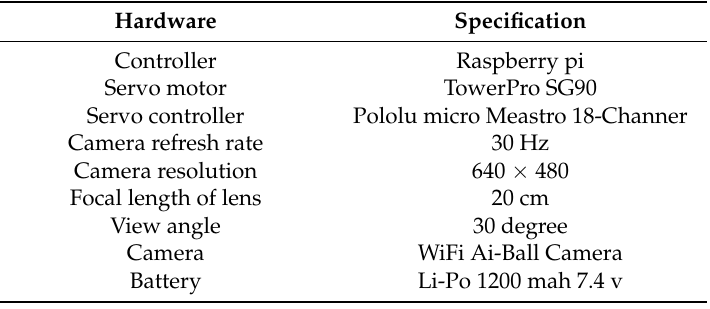
Table 2. Wearable KiliRo robot’s list of hardware. Table 2 . Wearable KiliRo robot’s list of hardware. Table 2 . Wearable KiliRo robot’s list of hardware.